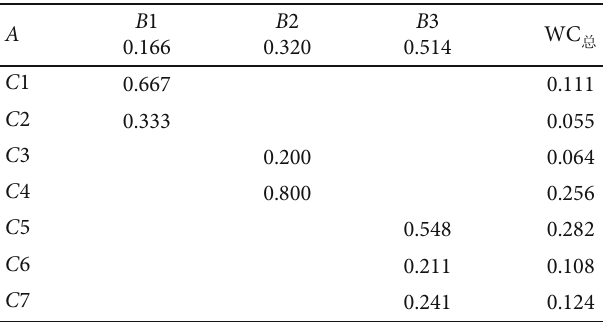
Table 6: Hierarchical general ordering of local learning information in aquifer water richness